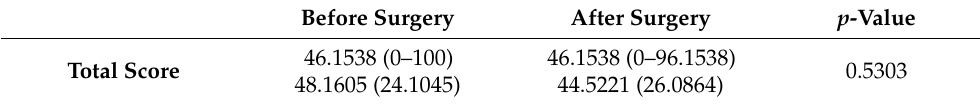
Table 1. Domain scores of the IIQ-7 questionnaire from women before and after surgery. Before Surgery After Surgery p